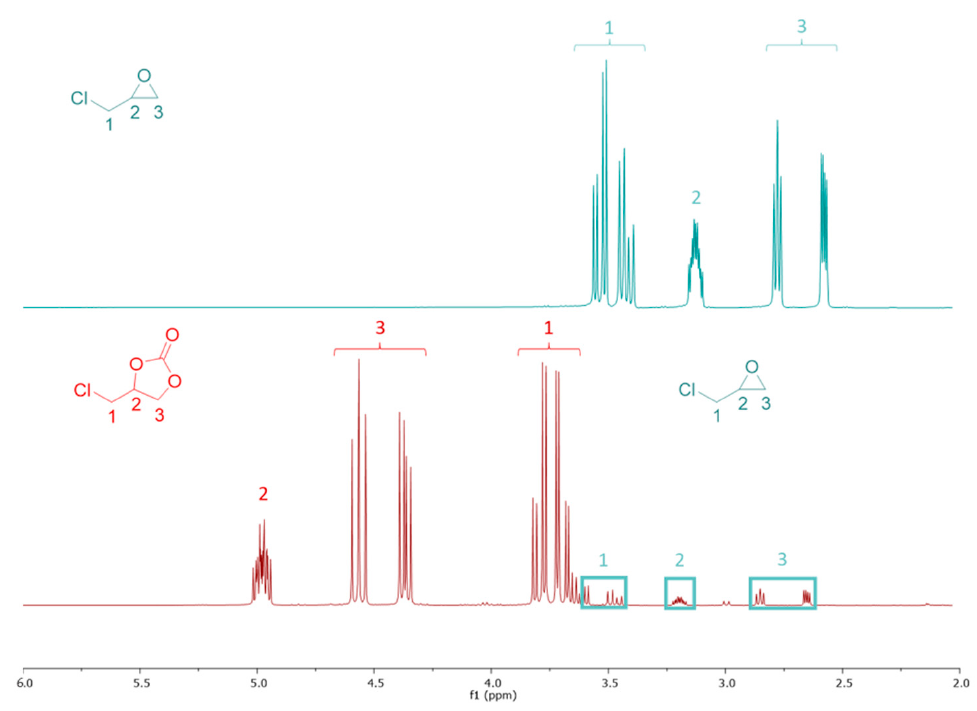
Figure 6. 1 H-NMR spectra of epichlorohydrin (blue) and a reaction crude (red).